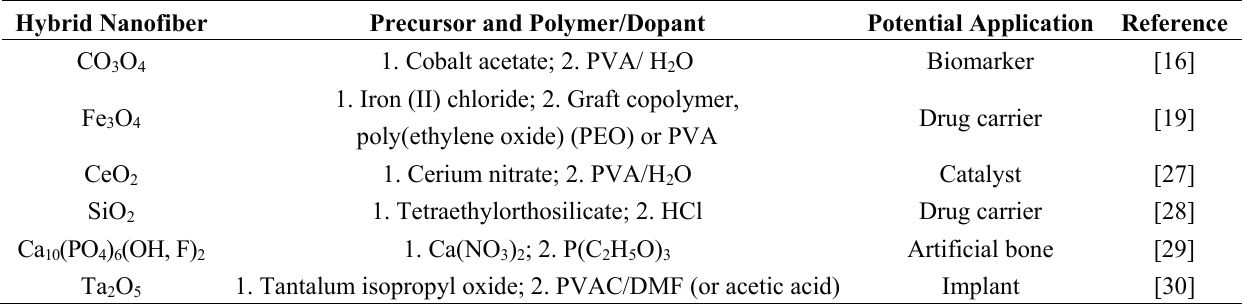
Table 1. Hybrid nanofibers and their